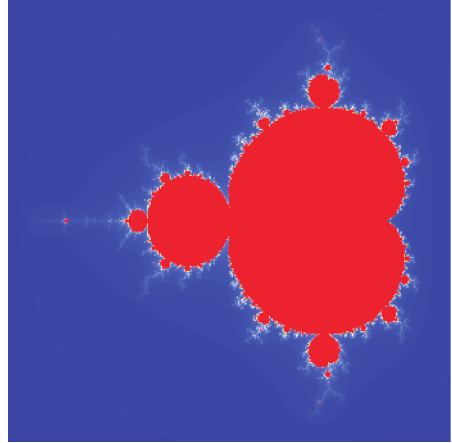
Figure 19: Cubic Mandelbrot set in JSOmhh.